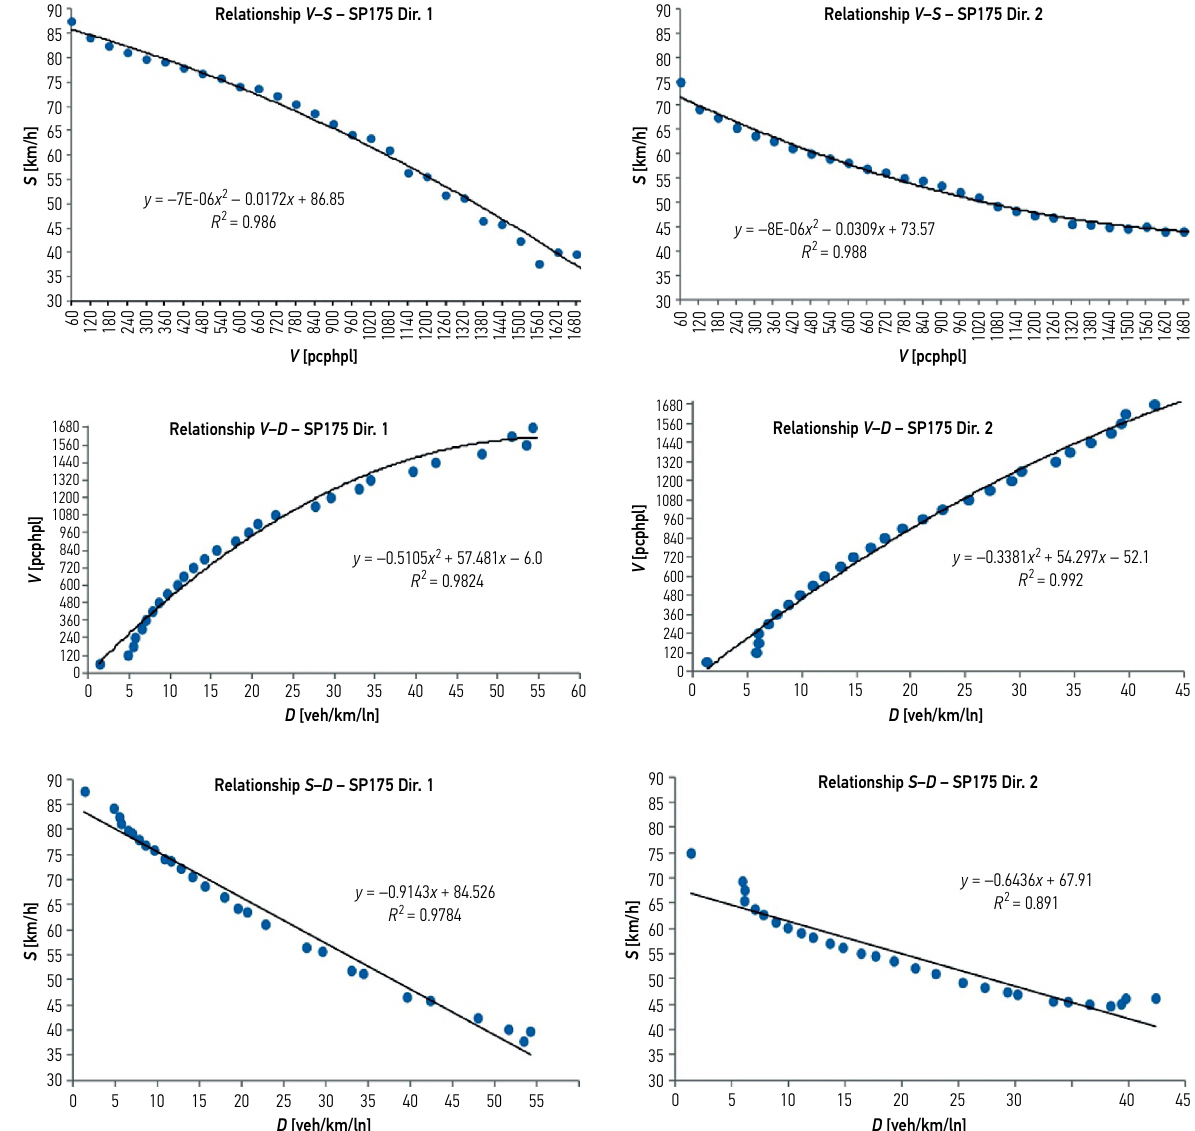
Fig. 6. Relationship between S , V and D for SP175 road